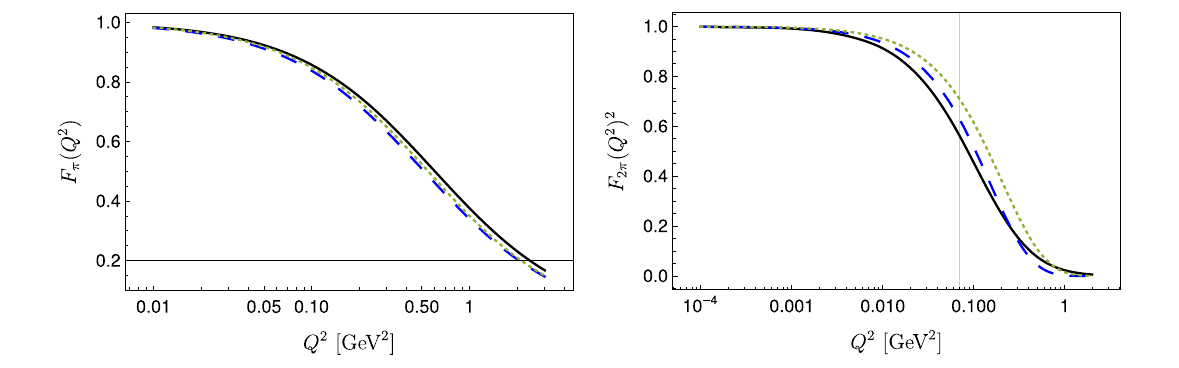
Fig. 12 Left panel: the pion form factor evaluated with the univer- sal model. The blue dashed lines represent the calculation obtained by √ λ = 0 . 51 GeV and γ = 0 . 01. Dotted lines repre- setting a = 1 . 4 ,